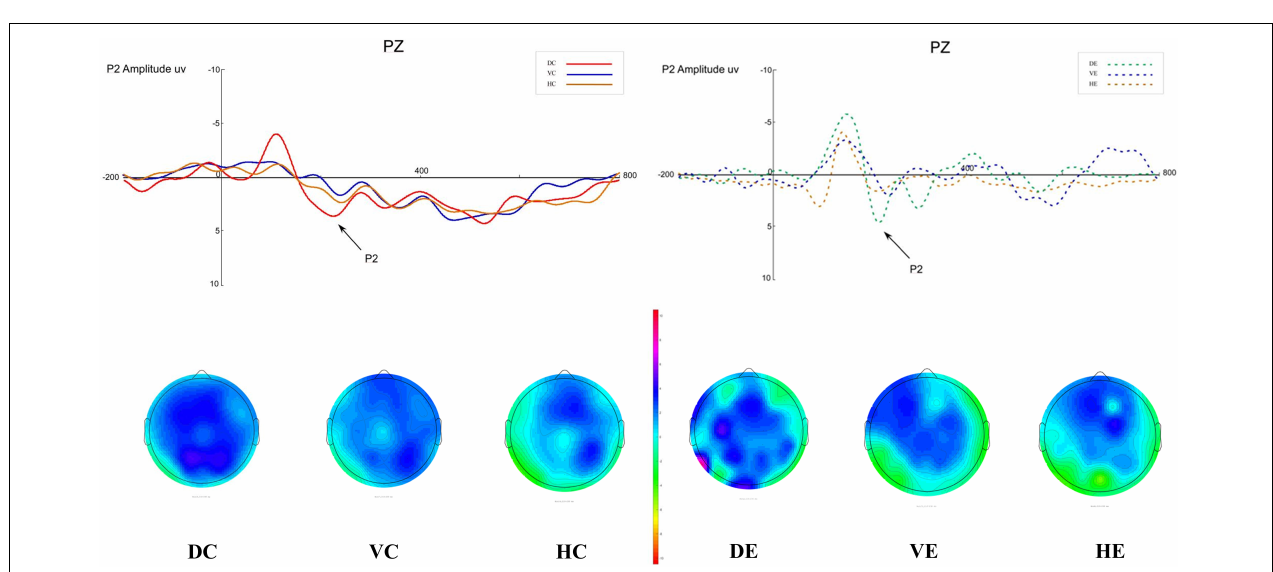
FIGURE 3 | ERP waveforms of the N400 for L2 Chinese (left) and L2 English (right) for OZ parietal leads. VC, Viewing Chinese; HC, Hand Writing Chinese; VE, Viewing English; HE, Hand Writing English. Topographic maps of experimental conditions.